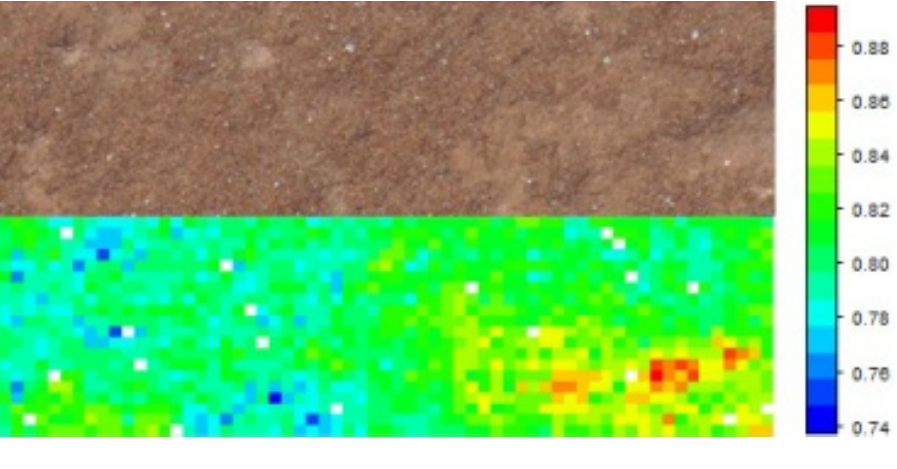
Figure 7. Surface of the sandstone sample ( top ) and derived emissivity values at 1,095 cm − 1 ( bottom ). White pixels are detector failures which are marked as bad pixels by the Reveal Pro